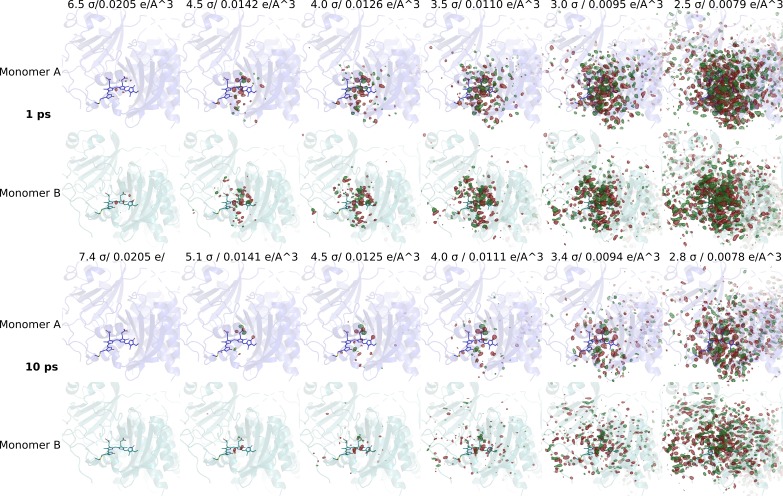
Significant difference electron density features observed.Difference electron density maps at 1 ps and 10 ps for monomer A and B are shown together with the DrBphPdark structure (monomer A: blue, monomer B: aqua). Red and green contour surfaces denote negative and positive densities, respectively. The maps are contoured at electron density levels as indicated. We determine the background level to be at 3σ for 1 ps and at 3.4σ for 10 ps, since below these levels random signals outside the chromophore region appear.